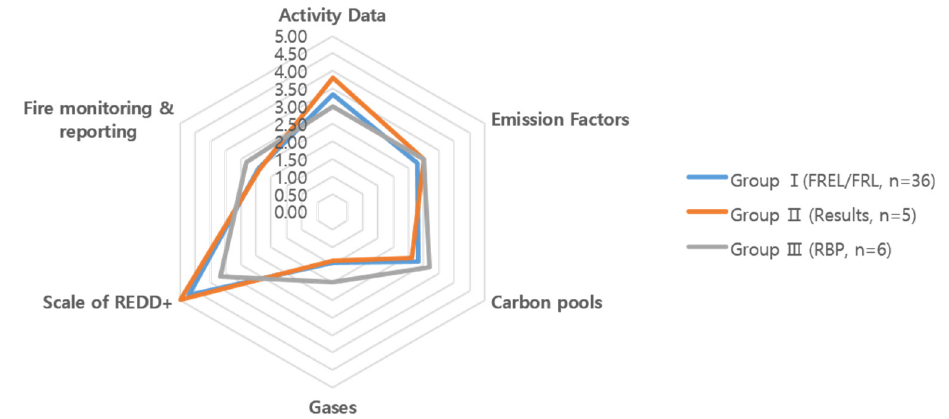
Figure 2. MRV capacities of REDD+ countries by group (FREL/FRL).